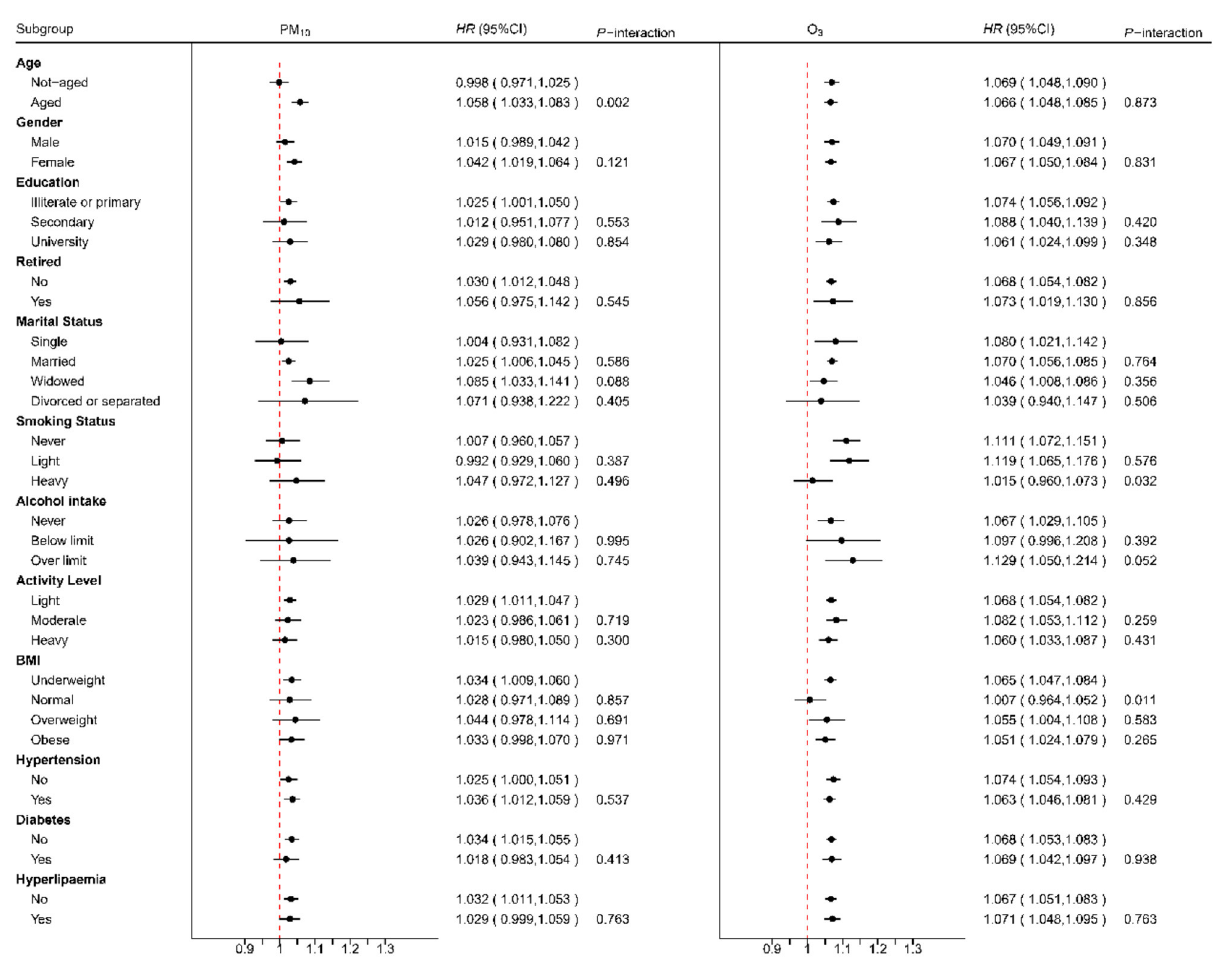
vs. aged, 1.074, 1.014–1.137; P interaction = 0.271) and circulatory system diseases ( HR , 95% CI : non-aged, 1.093, 1.038–1.150 vs. aged, 1.020, 0.984–1.058; P interaction = 0.060). In addition,